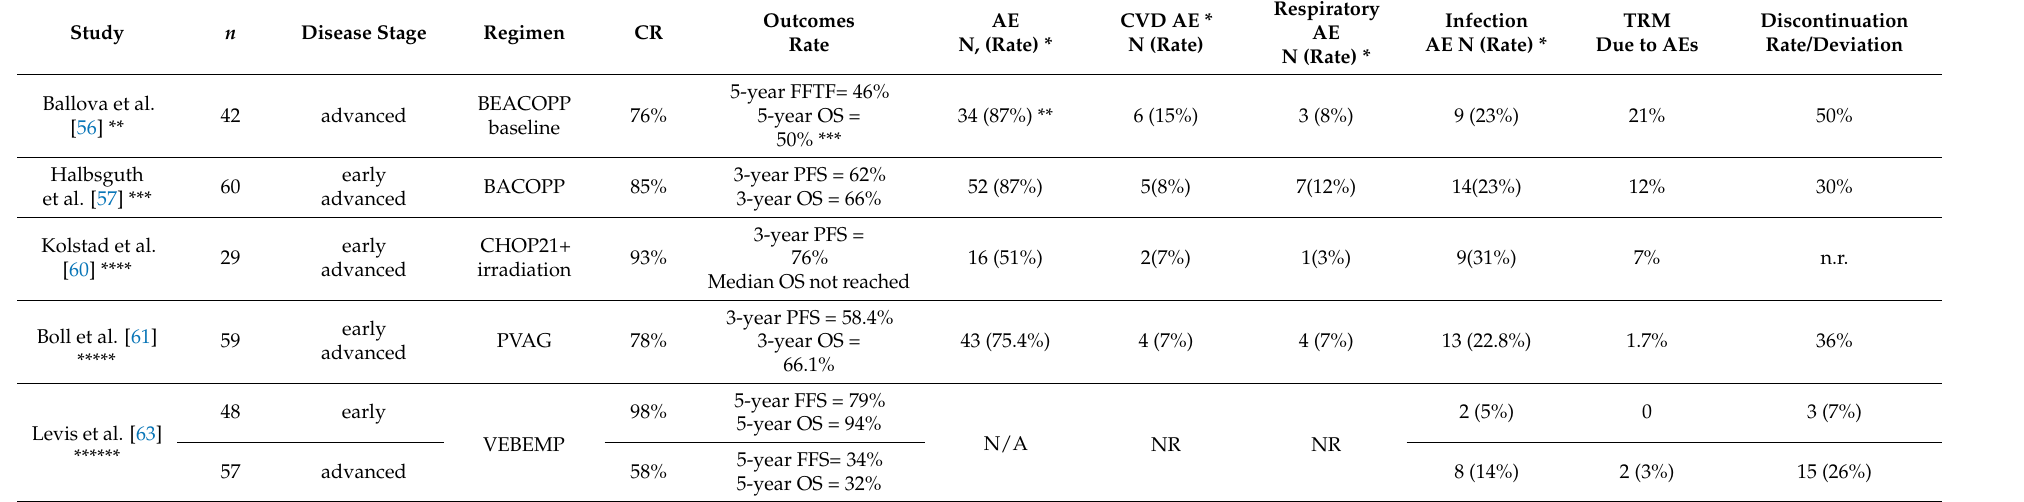
Table 3. Alternative Chemotherapy Regimens with Curative Intent in Elderly Patients with Hodgkin